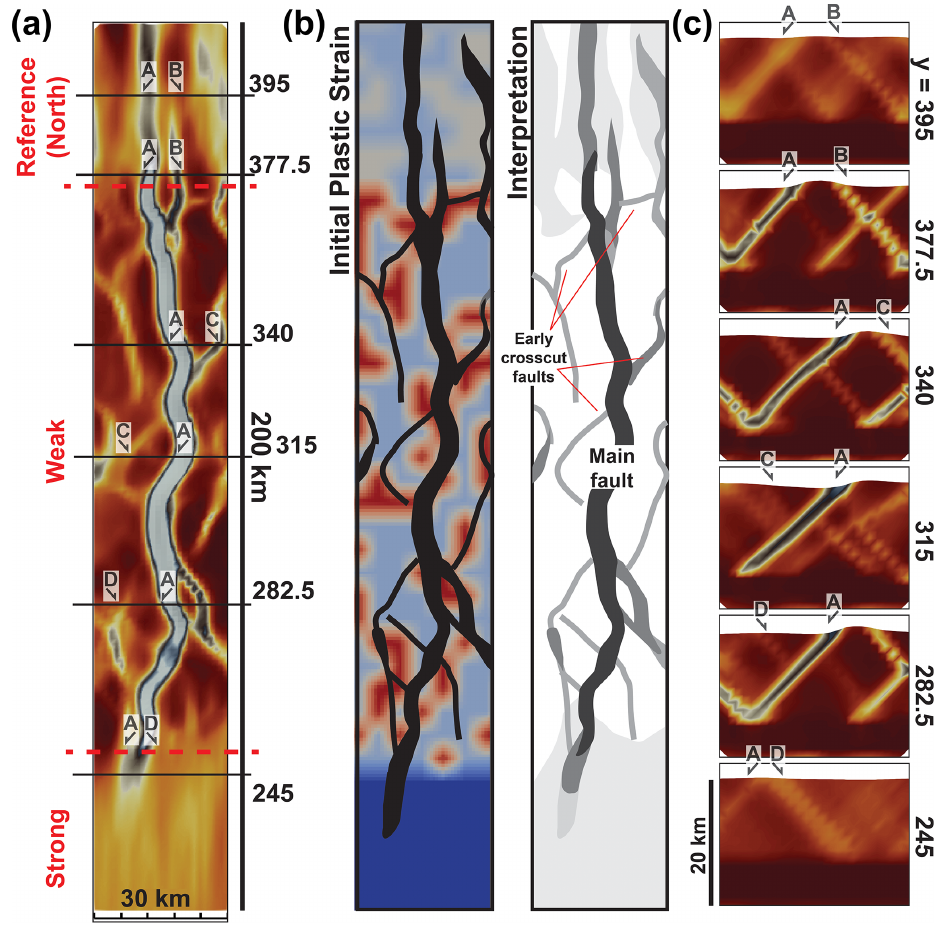
Figure 6. (a) Close-up map view image of a fault within the weak domain; see Fig. 4a for the location. The locations of cross sections and key faults are shown. (b) Interpretation of fault geometries within and immediately adjacent to the weak domain. The interpretation and the distribution of initial plastic strain between unit blocks are shown with the interpretation. (c) Cross sections across the model, showing the cross-cutting fault systems. Cross sections shown at 1 × vertical exaggeration. See (a) for the